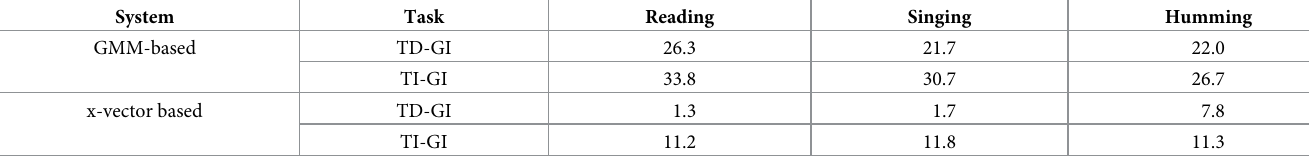
Table 7. EER% on both the GMM-based and x-vector based ASV tasks using multi-speaking style training data combination.